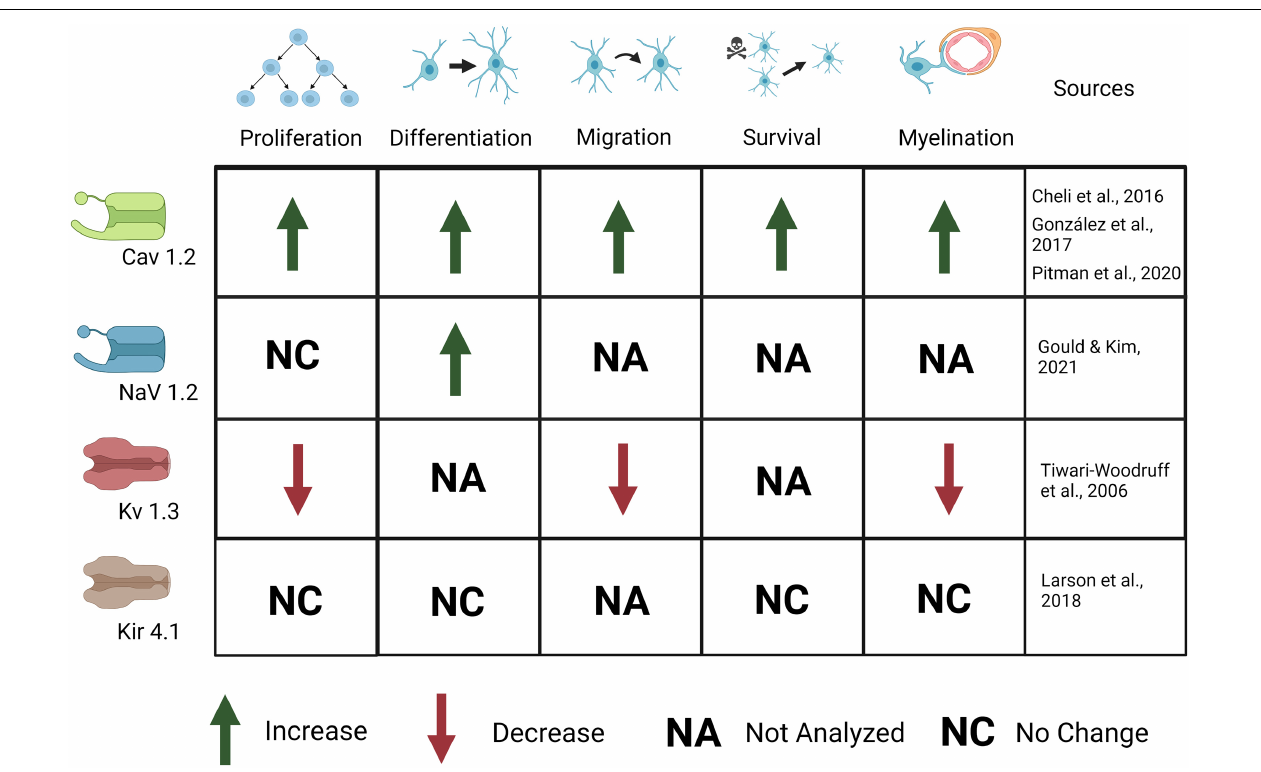
FIGURE 4 | Ion channels expressed in OPCs are important for OPC development and myelination. Activation of CaV1.2 causes an increase in OPC proliferation, differentiation, migration, survival, and myelination. Activation of Nav1.2 causes an increase in OPC differentiation but no change in proliferation. Activation of Kv1.3 causes a decrease in OPC proliferation, migration, and myelination. Kir4.1 activation causes no change in OPC proliferation, differentiation, survival, or myelination, although behavioral and electrophysiological defects (not depicted here) are